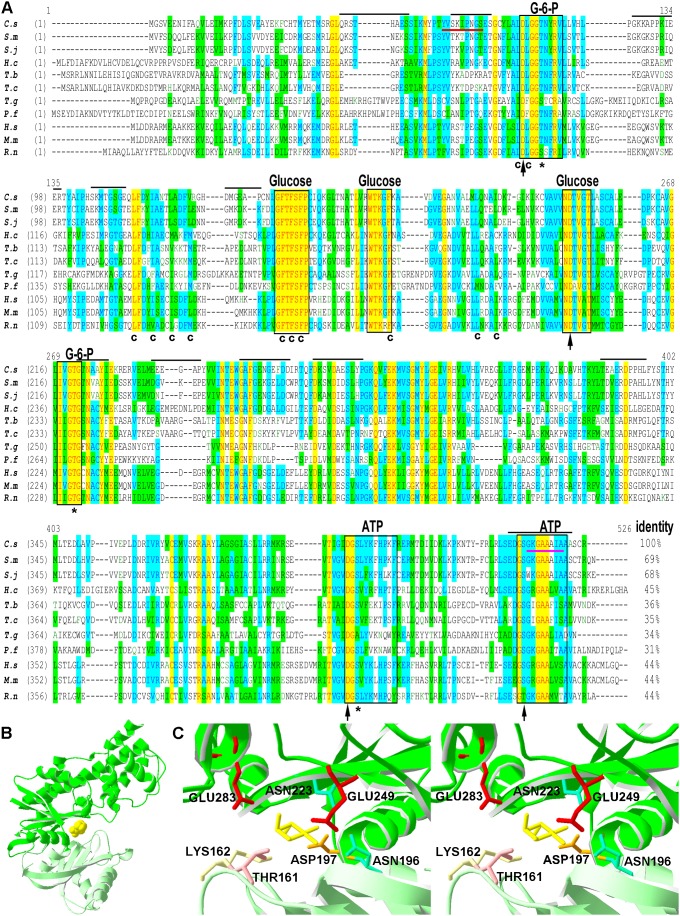
Sequence analysis and putative tertiary modeling of CsHK.(A) Alignment of the amino acid sequence of CsHK with that of HKs from other species. Clonorchis sinensis (C. s, GAA52956.1), Schistosoma mansoni (S. m, XP_002575647.1), Schistosoma japonicum (S. j, CAX74187.1), Haemonchus contortus (H. c, CAB40412.1), Trypanosoma brucei (T. b, CAC69958.1), Trypanosoma cruzi (T. c, AAL93565.1), Toxoplasma gondii (T. g, BAB55664.1), Plasmodium falciparum (P. f, AAA29613.1), Homo sapiens (H. s, NP_000153.1, Mus musculus (M. m, NP_034422.2), and Rattus norvegicus (R. n, NP_036866.1). The conserved domains for glucose, ATP and G6P were illustrated in the rectangles. The black arrows indicate the binding sites of the sugar moiety of G6P. The asterisks indicate the binding sites of the phosphate moiety of G6P. The residues that are marked “C” are present in the conserved hydrophobic channel. The 11 putative, linear B-cell epitopes with higher credibilities are marked with an overline. The putative connecting region I and α 13 helix region are respectively marked with red underline and magenta underline. (B) Ribbon drawing of the CsHK putative structure model complexed with glucose (yellow, ball model). The spatial relationship of the large domain (green) and the small domain (light green) exhibit a closed form. The two domains are connected by connecting regions I–III. Glucose is shown as bound in the binding cleft of the domains. (C) Stereo view of the putative glucose-binding sites in CsHK according to the molecular model of the HK from S. mansoni (PDB entry: 1BDG) [49]. Glucose (yellow stick) binds to the bottom of the deep cleft between the large domain (green) and the small domain (light green). The glucose-binding sites, including ASP197 (brown stick), ASN223 (light blue stick), GLU249 (red stick), GLU283 of the large domain, THR161 (pink stick), LYS162 (light yellow stick) of the small domain, and ASN196 of connecting region II (light green), are indicated.